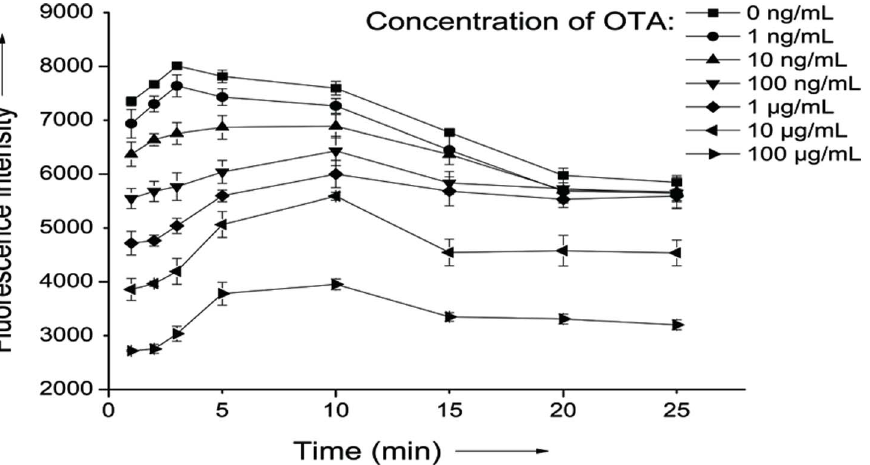
Figure 2. Optimization of the incubation time after aptamer complementary strand and PicoGreen were added into the different concentration of OTA and aptamer